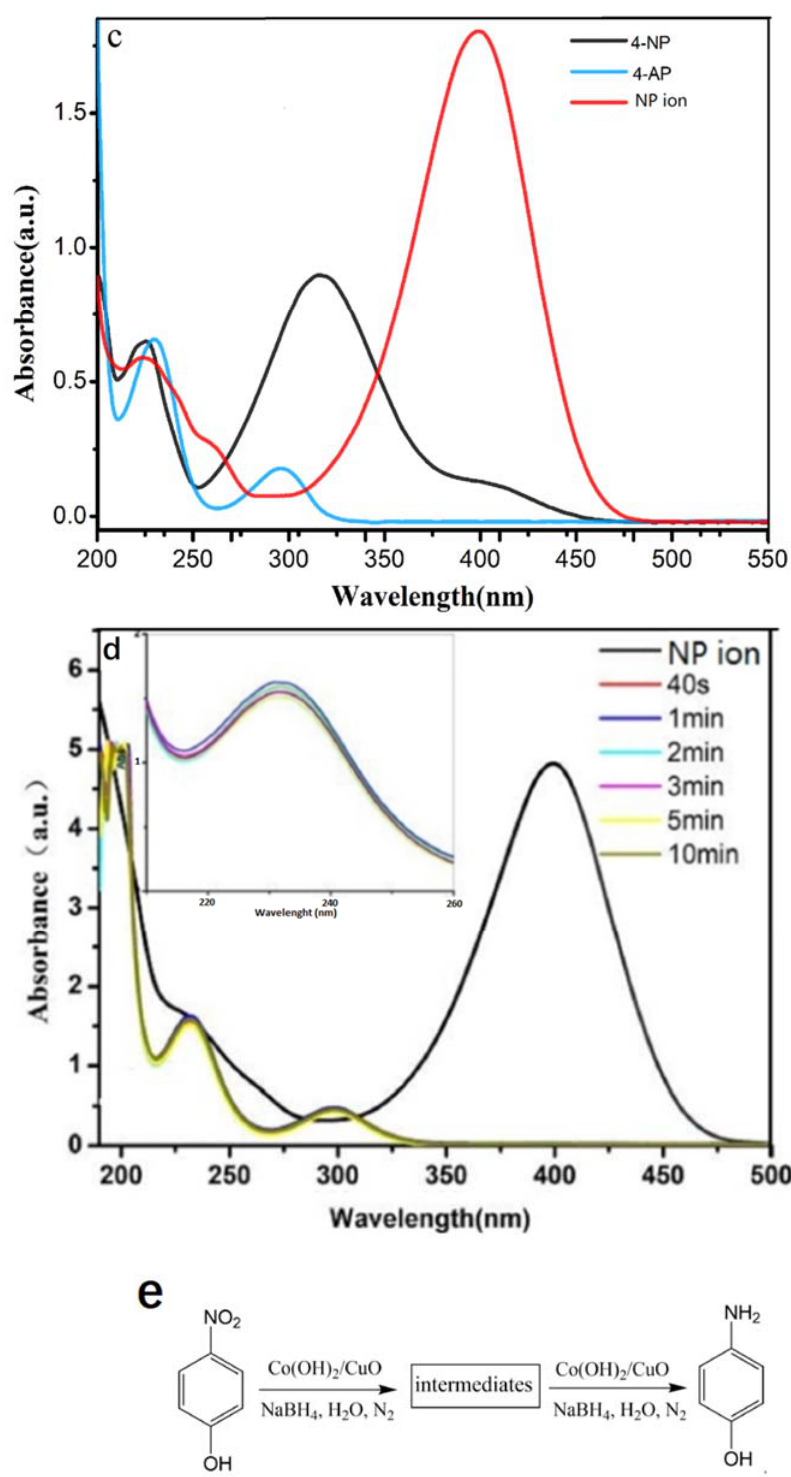
Figure 1. UV-Vis absorption spectra of 4-NP reduction of ( a ) Solution 1, ( b ) at a wavelength 230 nm of Solution 1, ( c ) at the same molarity of 4-NP, 4-NP ion, and 4-AP, ( d ) in Solution 2 and ( e ) the Figure 1. UV ‐ Vis absorption spectra of 4 ‐ NP reduction of ( a ) Solution 1, ( b ) at a wavelength 230 nm hydrogenation scheme of the of Solution 1, ( c ) at the same molarity of 4 ‐ NP, 4 ‐ NP ion, and 4 ‐ AP, ( d ) in Solution 2 and ( e ) the hydrogenation scheme of the reaction.